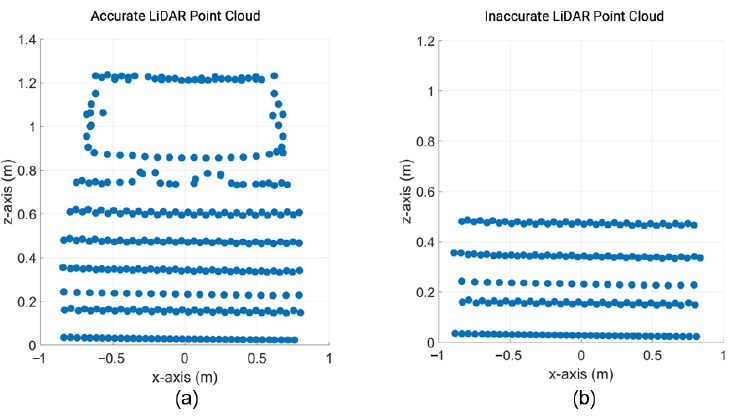
Figure 30. ( a ) Exemplary visualization of accurate LiDAR point cloud obtained from a simulated vehicle at 12.0m. ( b ) Exemplary visualization of inaccurate LiDAR point cloud obtained from a simulated vehicle at 12.0m. The actual width and height of the vehicle, 1.76 × 1.25m, can not be estimated from the inaccurate data.